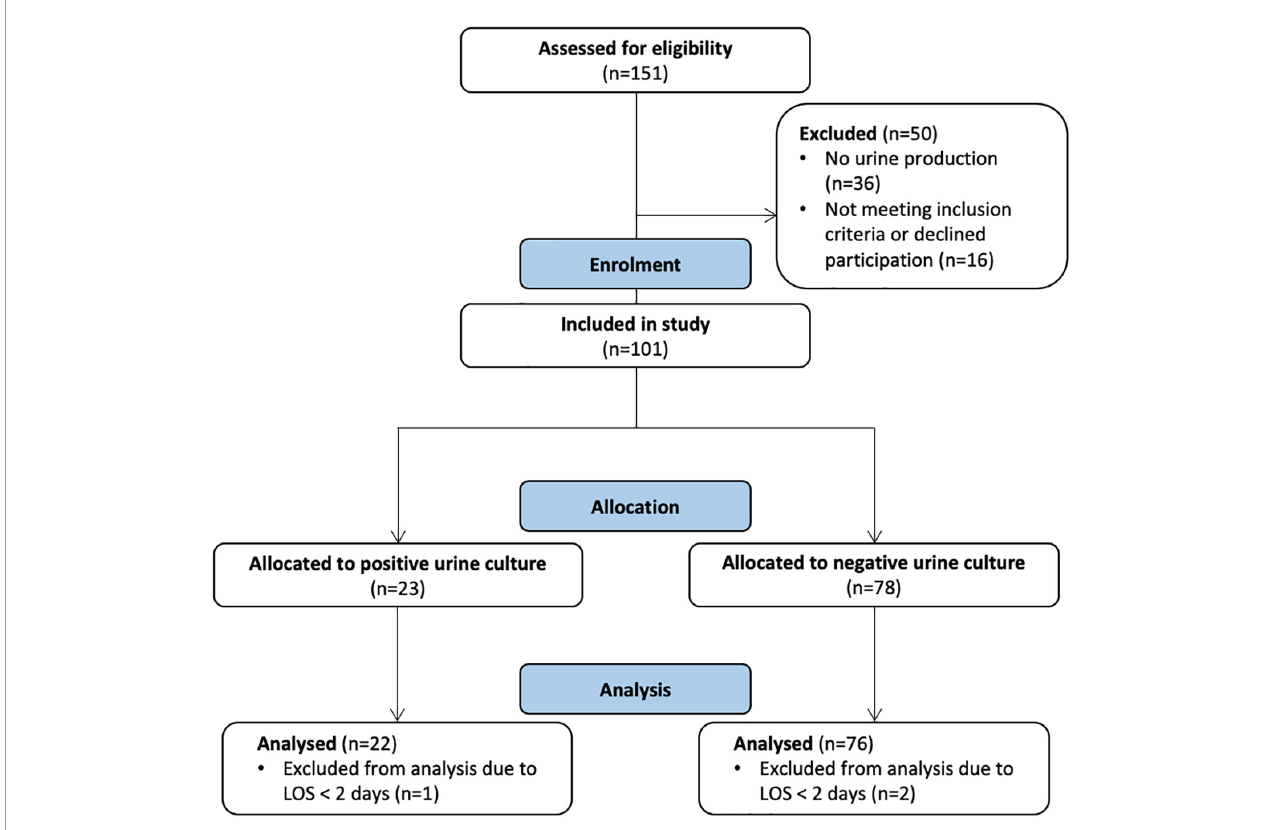
FIGURE1 CONsolidated Standards of Reporting Trials (CONSORT) flow diagram for the progress of enrollment and allocation based on bacteriuria (urine study